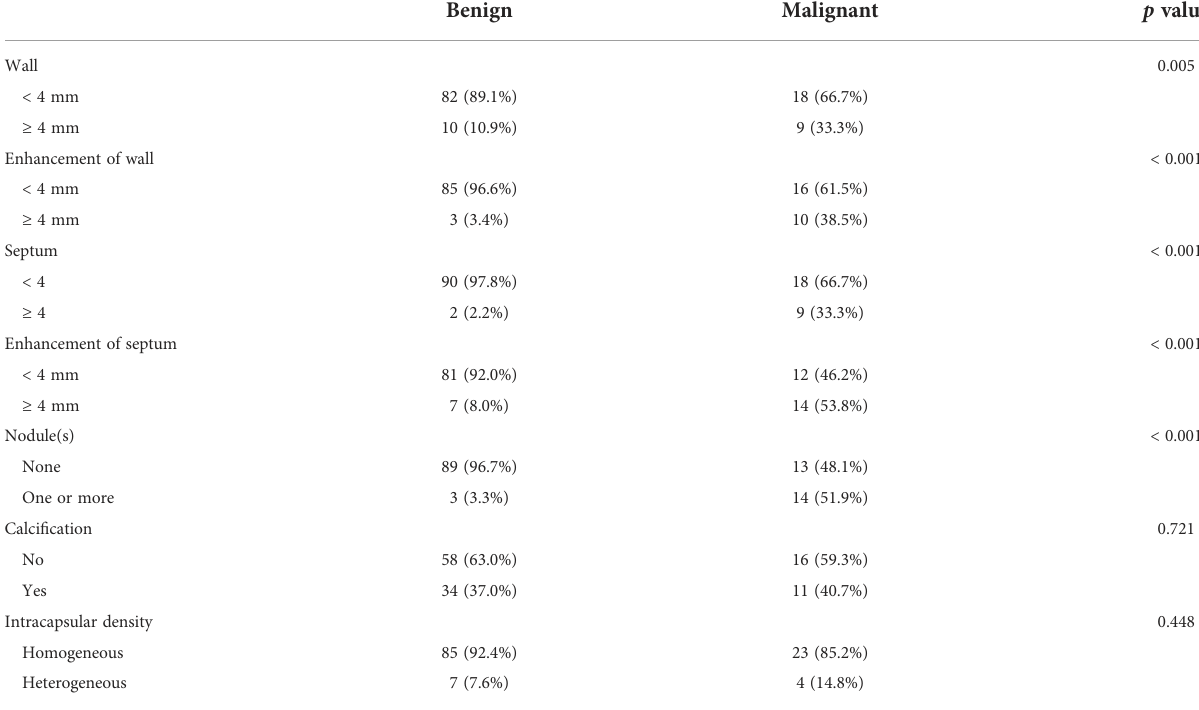
TABLE 2 Characteristics of lesions on CT images between benign and malignant cystic renal